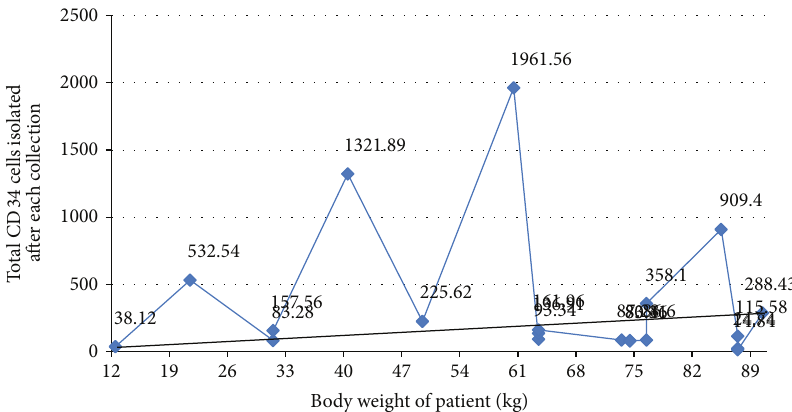
Figure 3: Graphical representation of the total CD34 + cells isolated after each collection procedure versus the body weight of the patient in kgs. A mean point is plotted from patients of different kg body weights but gives almost the same number of CD34 + progenitor cells enumerated per kg body